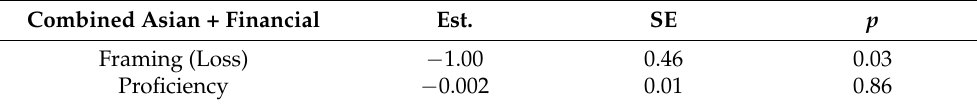
Table 8. Spanish items (Asian disease and Financial crisis